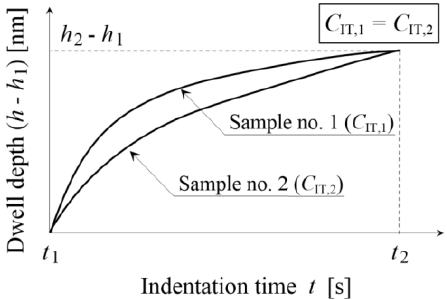
Figure 6. Indentation curve for the creep phase of two hypothetical samples with the same creep coefficient C IT .